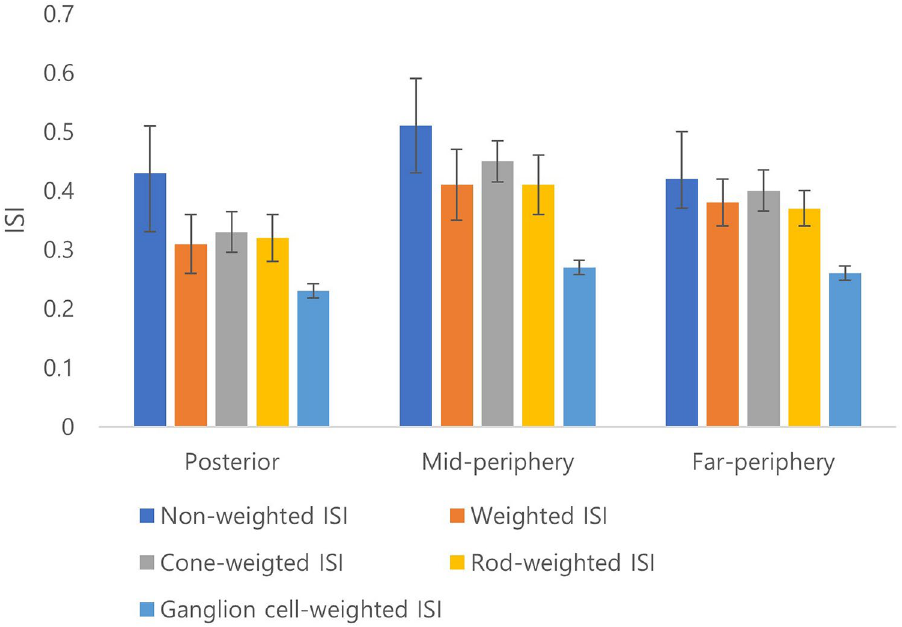
Figure 1. The distributions of weighted and non-weighted ischemic index (ISI) of nonperfusion region (NPR) with leakage among retinal